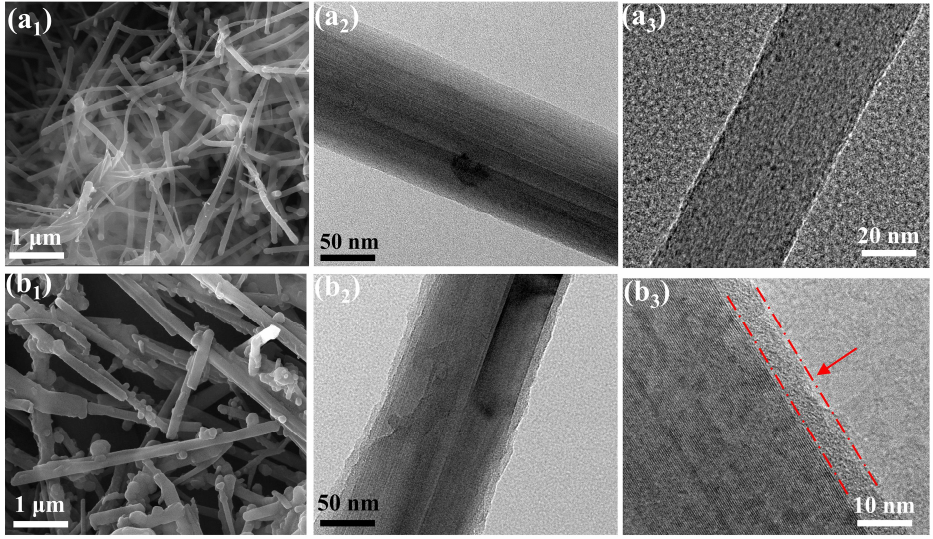
Figure 4. SEM ( a 1 , b 1 ) and TEM ( a 2 , a 3 , b 2 , b 3 ) images of ( a ) CNFs, ( b ) PDA@CNFs–1.